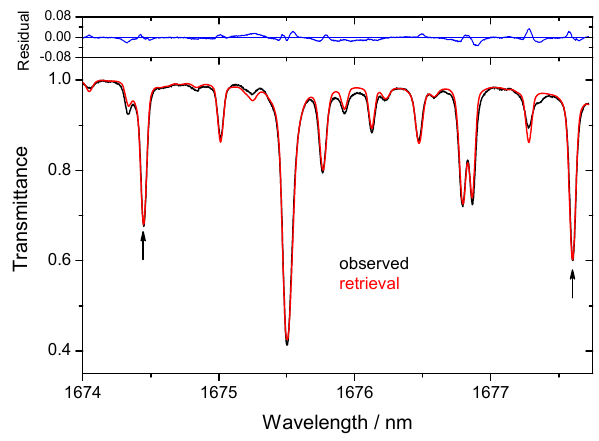
Fig. 8. CH 4 photoabsorption spectrum for OSA retrieval. Black curve denotes the observed spectrum and red one calculated. The arrows are the photoabsorption lines of CH 4 .